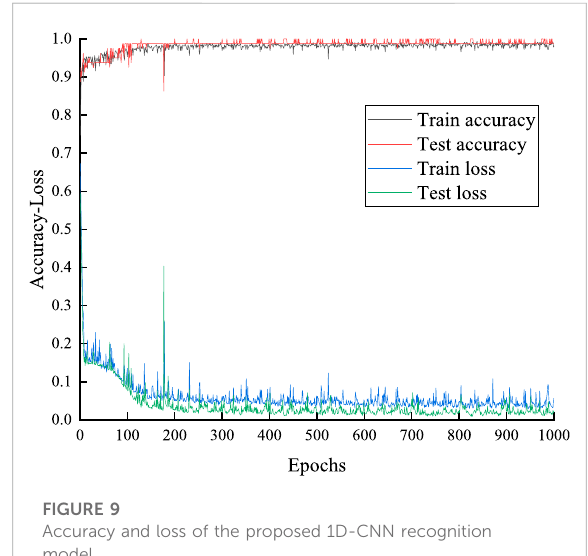
FIGURE 9 Accuracy and loss of the proposed 1D-CNN recognition